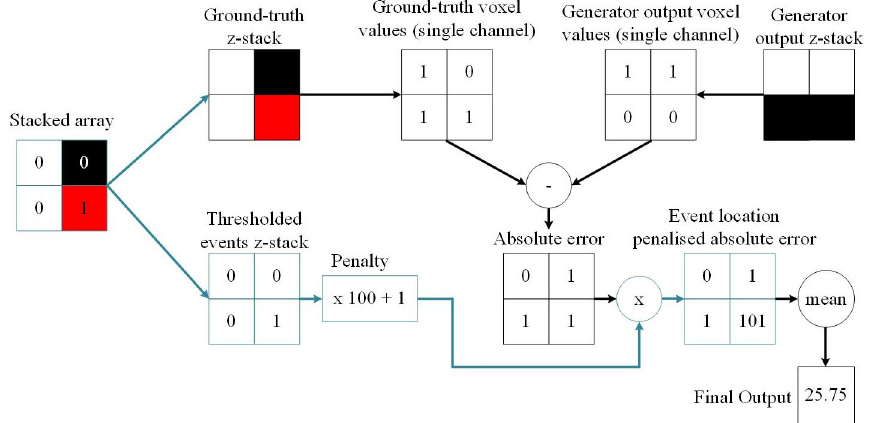
Fig 2. A diagram of the ELP-MAE loss function that was used to train generative neural networks. The ELP-MAE loss function penalises areas where mitochondrial events should have been predicted in the generator output. The function first splits the stacked array into the ground-truth and the binarised events z-stacks. The absolute error between the ground-truth and generator output z-stacks is calculated. The thresholded events z-stack that contains only the localised events, is multiplied with a user-defined penalty value (e.g. 100). A value of 1 is then added to all elements in the array to prevent the elimination (multiplication with zero) of error values in areas where mitochondrial events are not present. The final output of the loss function is the mean of the error values after the penalty factor was applied. This is a much larger value than what would have been obtained with the MAE loss. The variations of the ELP-MAE on the standard MAE loss are shown with blue